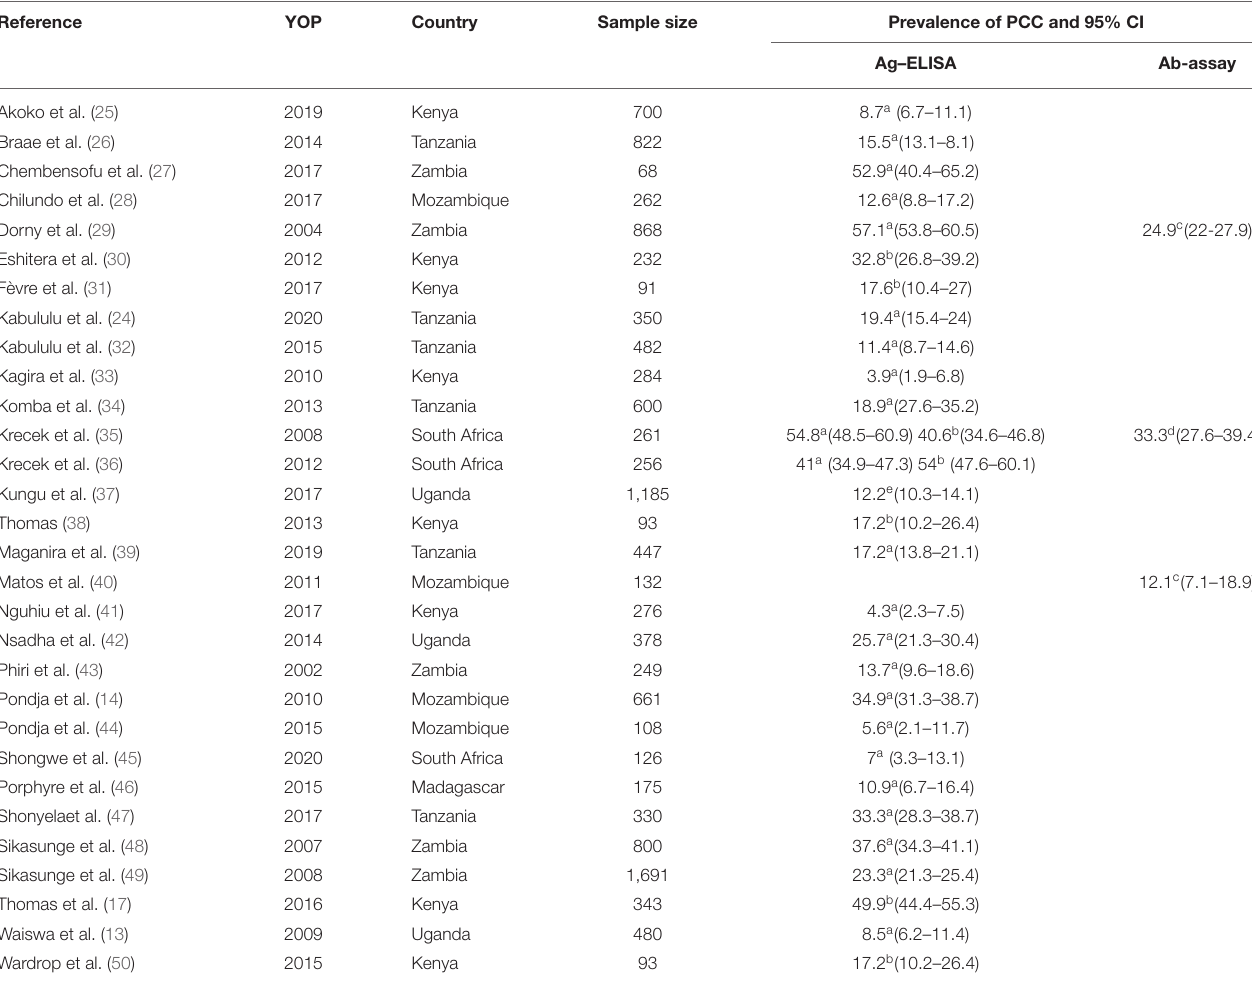
TABLE 1 | Prevalence of porcine cysticercosis based on immunological diagnostic